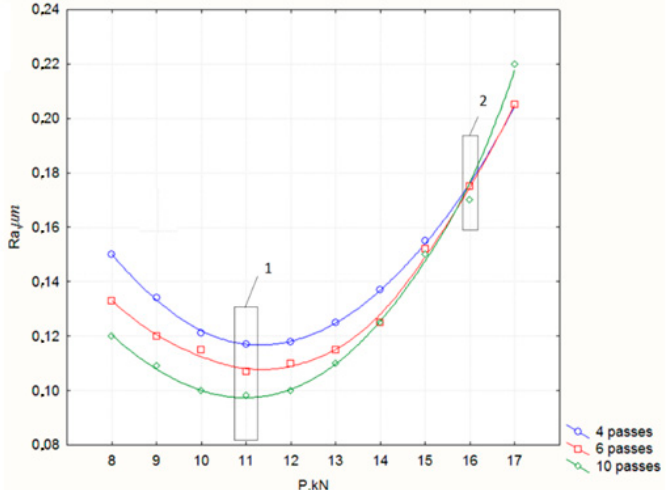
Figure 10. The surface roughness variation depending on the WB indenter pressure for 75-50-03 cast iron work piece.